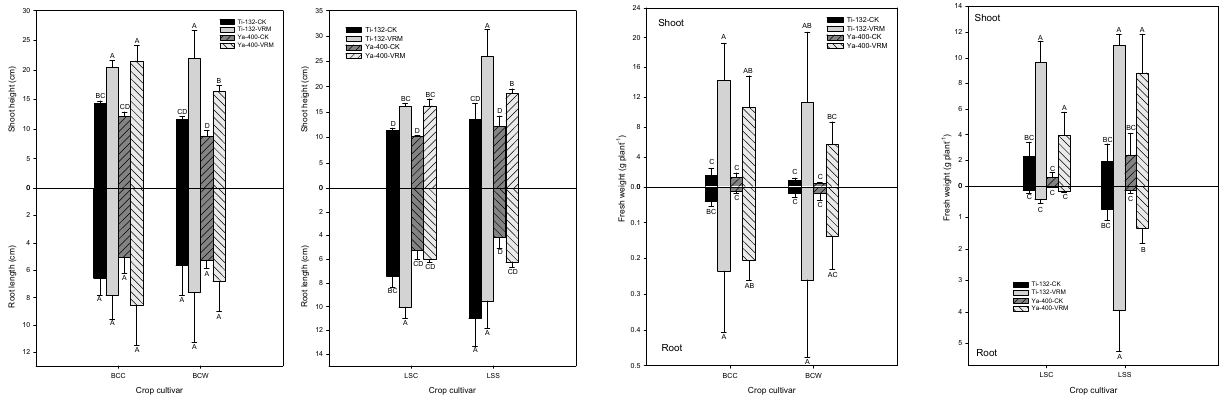
Figure 1. Effects of different treatments on the root length, shoot height, and fresh weight of pak choi and lettuce. The meaning of each code is the same as Table 1. Different letters indicate significant differences across treatments as determined by one-way ANOVA analysis (LSD test, p < 0.05, n = 3).